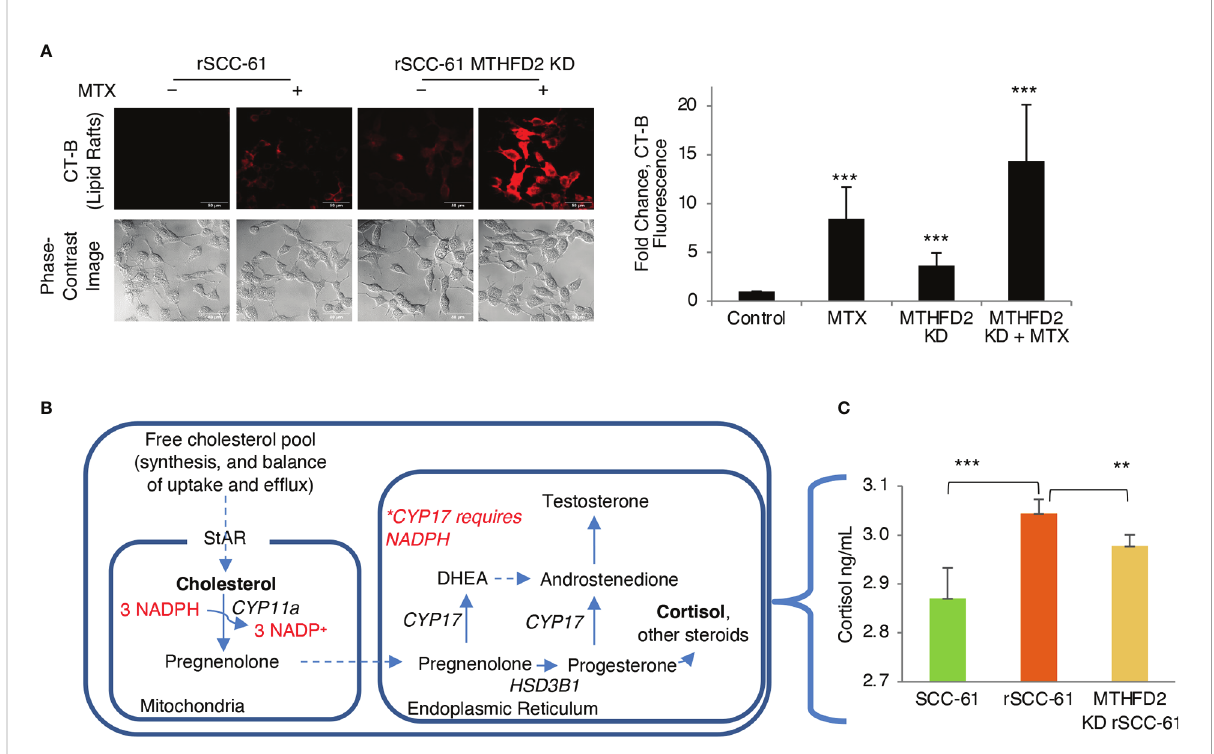
FIGURE 7 Regulation of lipid rafts and steroidogenesis by MTHFD2. (A) Knockdown of MTHFD2 in rSCC-61 cells increases lipid rafts and the effects are further enhanced by inhibition of dihydrofolate reductase (DHFR) by methotrexate (MTX) (scale bar 50 m m). Quanti fi cation is shown on the right panel ( p values ***<0.001, n=3). (B) Abbreviated schematic of steroidogenesis highlighting the requirement for NADPH in the mitochondria to support CYP11a activity. (C) Measurement of cortisol in cell extracts showing statistically signi fi cant higher cortisol in rSCC-61 relative to SCC-61 cells, and attenuation of its levels in MTHFD2 KD rSCC-61 cells. ( p values **0.01-0.001, ***<0.001,